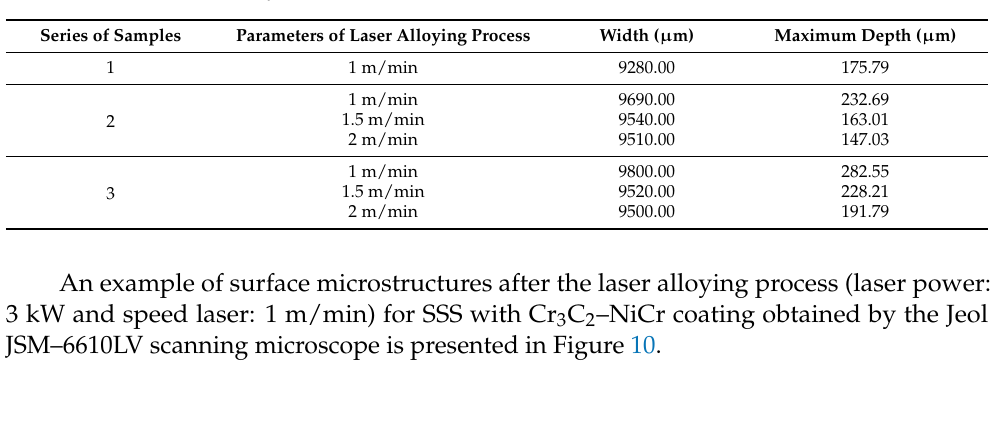
Figure 9. Cross-section of the entire alloyed zone for sample 3. Table 4. Results of the alloyed